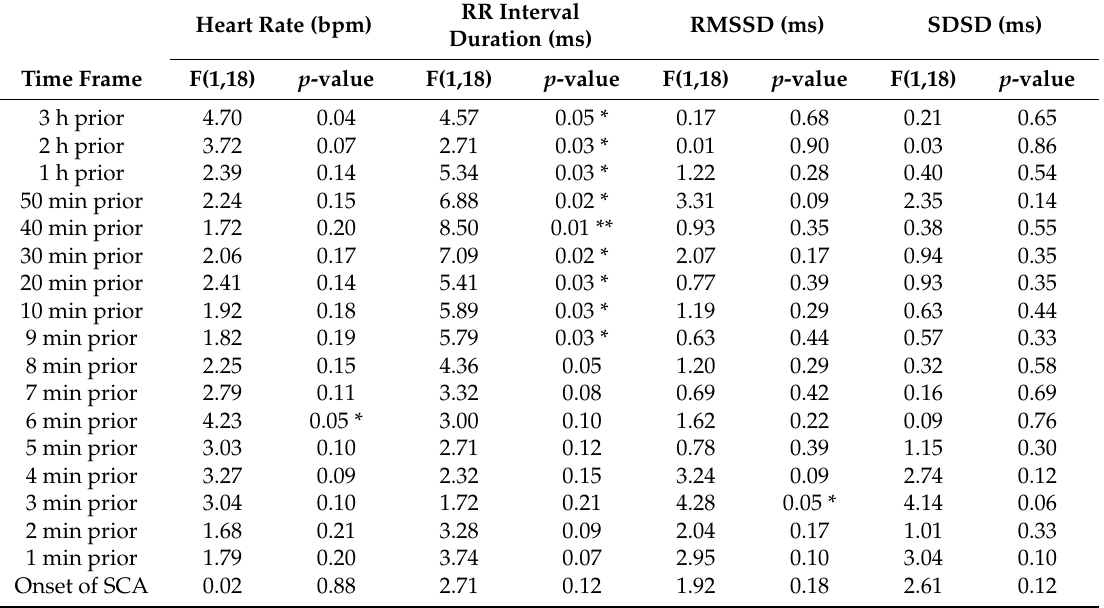
Table A2. Tabular summary of the repeated measures ANOVA conducted on the ECG features extracted from the normal patient cohort vs. SCA patient cohort ( n =